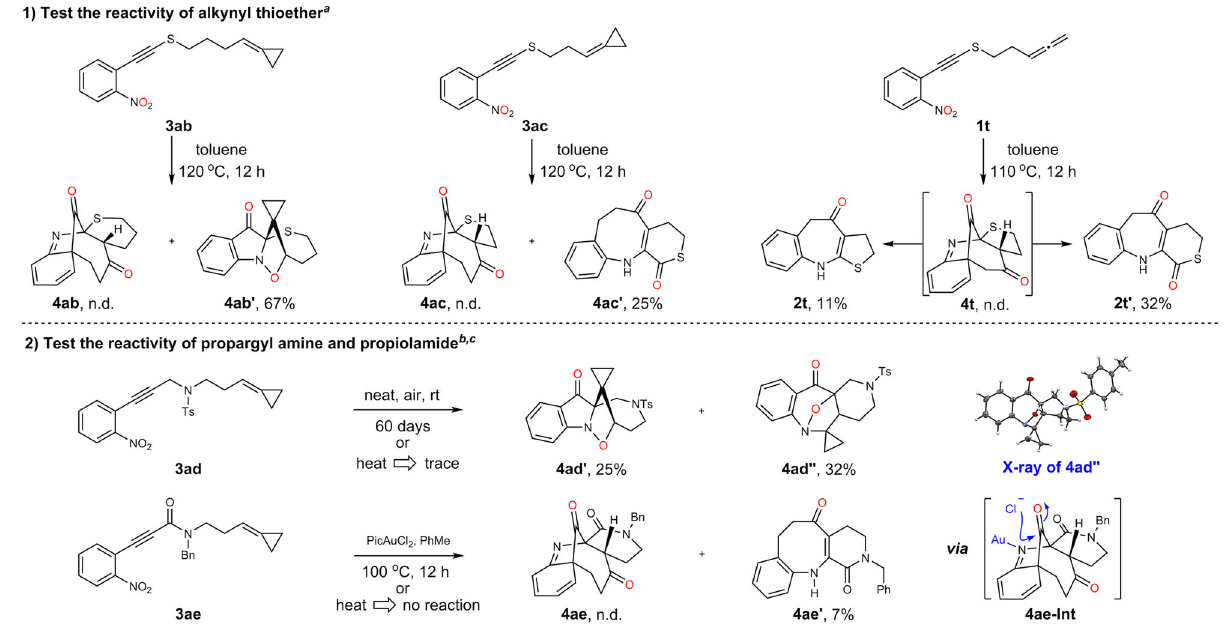
Fig. 6 | Test the compatibility of other type substrates. a The solution of 3 in toluene (0.03M) was stirred under N 2 atmosphere at 110 or 120 o C for 12h; b The viscous oil 3ad (50mg) in a 25mL round bottom fl ask with a stopper was stood at roomtemperaturefor60days; c Tothesolutionof 3ae inPhMe(0.03M)wasadded